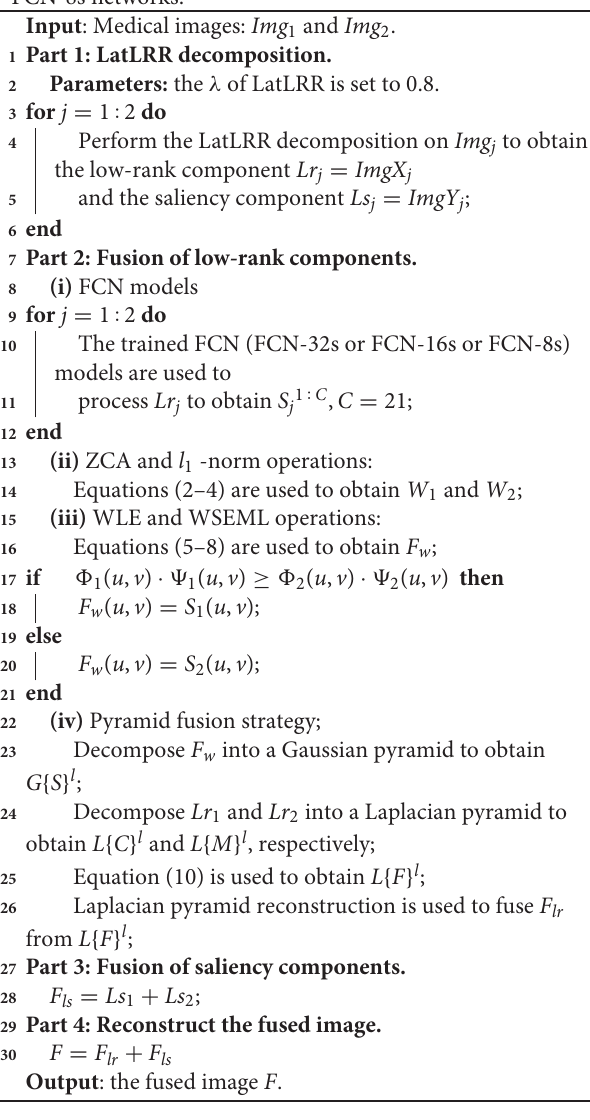
Algorithm 1: LatRR-FCN-32s, LatRR-FCN-16s, and LatRR- FCN-8s